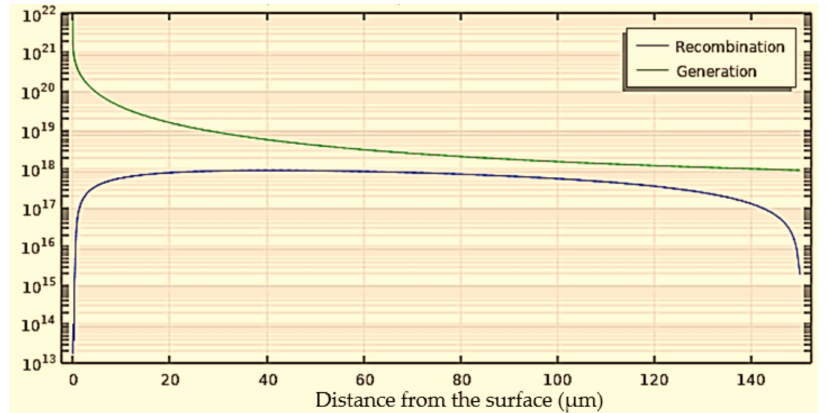
Figure 12. Generation and recombination rates through the thickness of the